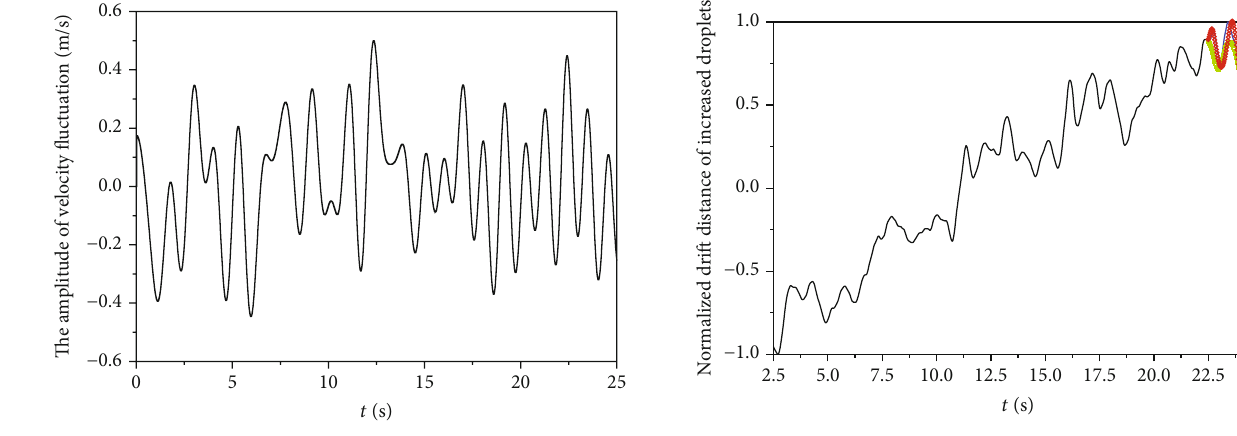
Figure 18: The signal for fl uctuation of random lateral wind with 2.5m/s mean value.